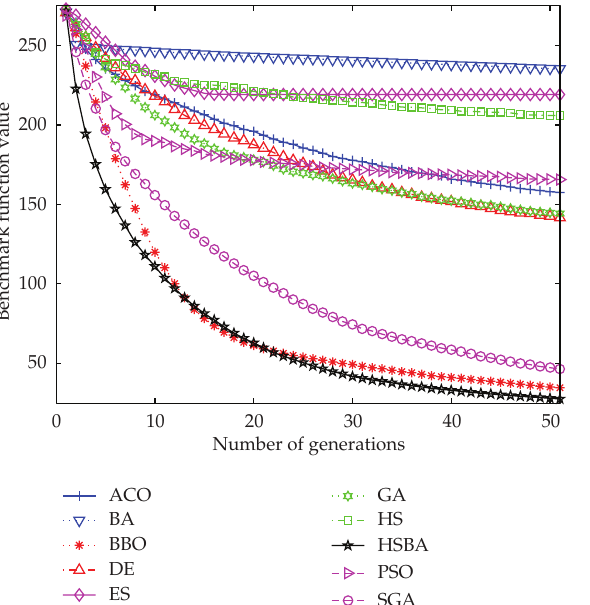
Figure 9: Comparison of the performance of the different methods for the F09 Schwefel 2.26 function.